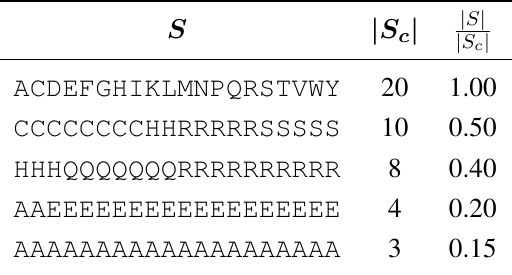
Table 1. The compressibility of AA-set strings correlates with evolutionary conservation. S represents the ASCII AA-string, and S the respective DEFLATE-compressed c